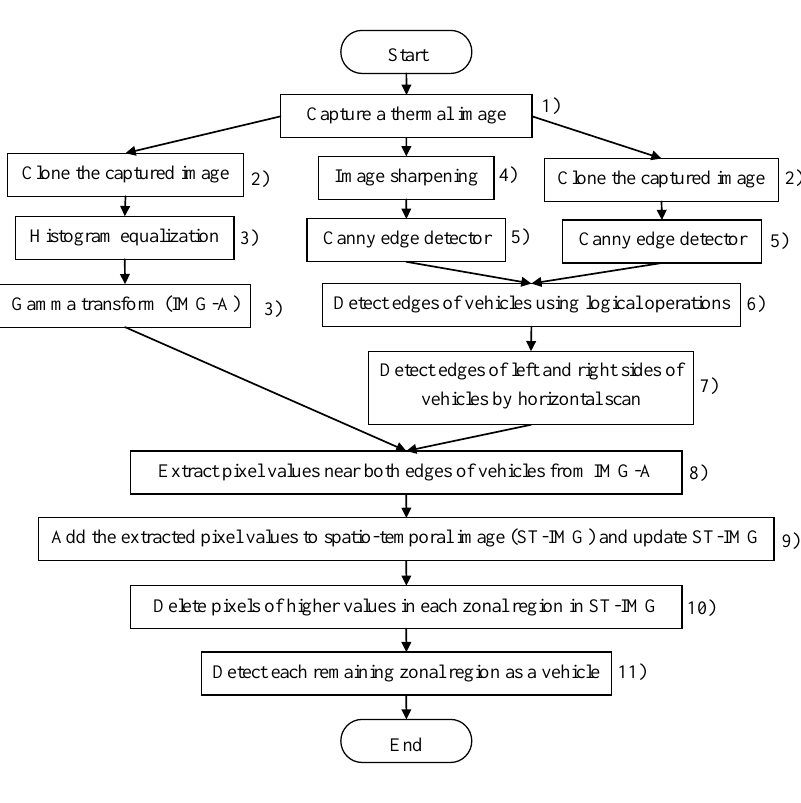
Figure 9. The flowchart of our new method.